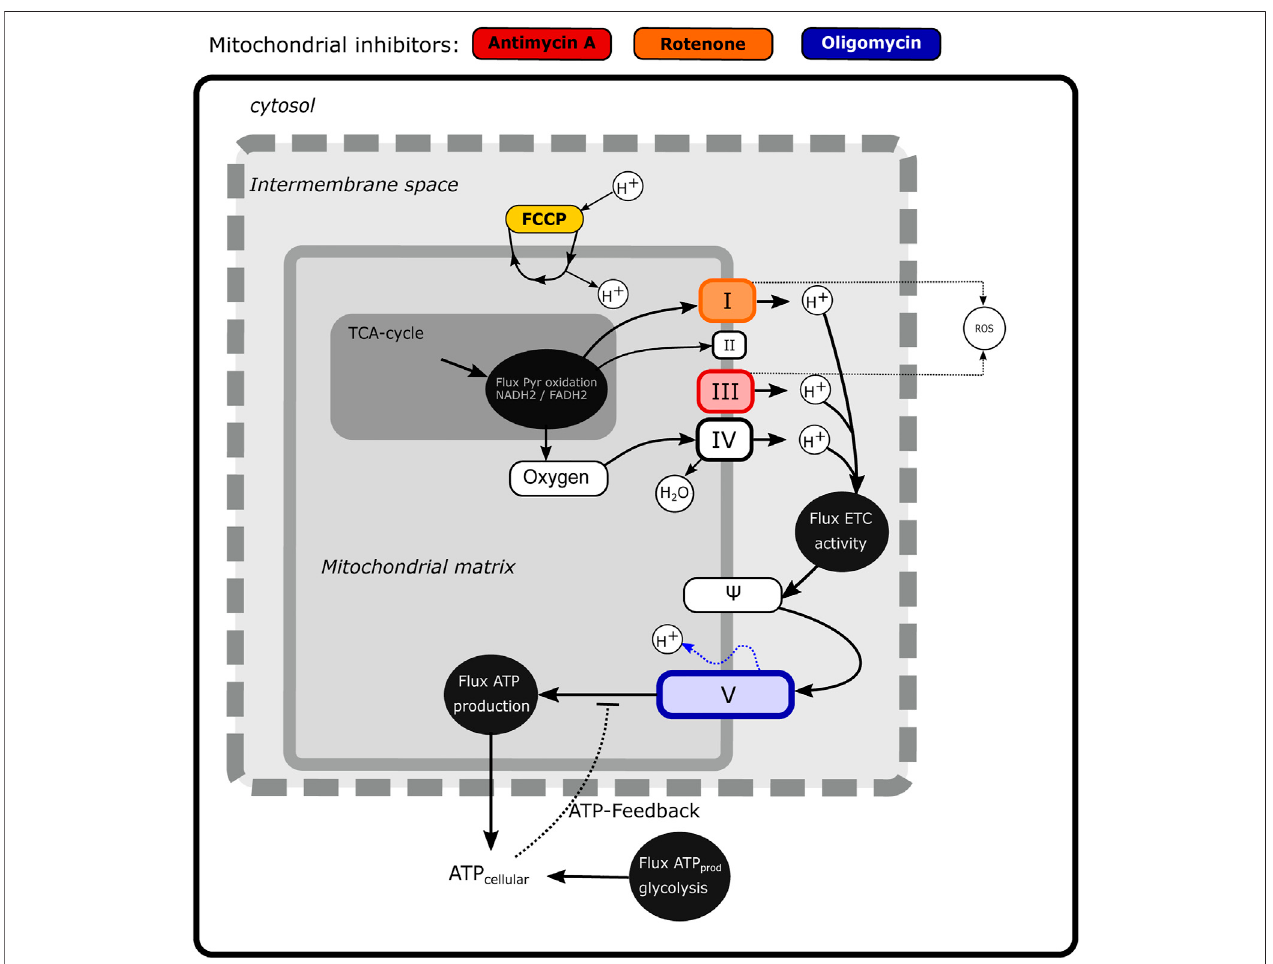
FIGURE2| Schemeillustrating mechanistic informationonmitochondrialenergygenerationandmodeledcomponents.Thestatevariablesthatareincluded inthe model (Oxygen and Ψ ) areshown inthe whiteboxes, while fl uxesaredepictedby blackcircles. Thenon-modelledTCA cycle isindicatedin darkgray.The sitesofaction of four classical mitochondrial inhibitors (FCCP, antimycin A, rotenone and oligomycin) are shown in color.